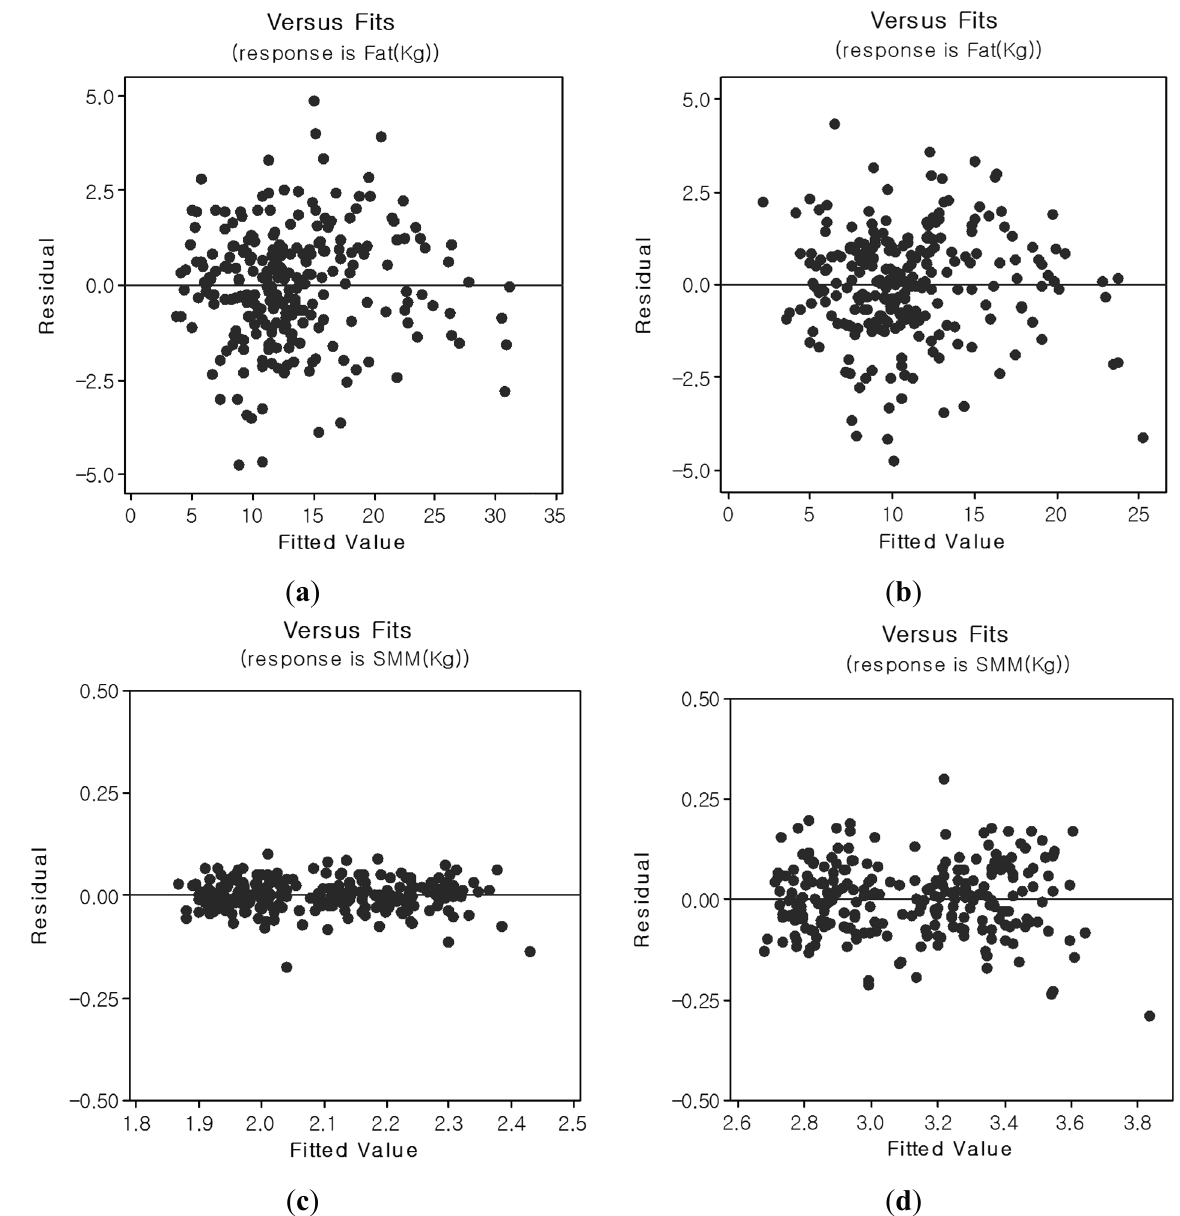
Figure 6. Residual vs. fitted plots for body fat and skeletal muscle mass (SKM) for the FF and PK pathways (( a ) body fat [FF]; ( b ) body fat [PK]; ( c ) skeletal muscle mass [FF]; and ( d ) skeletal muscle mass